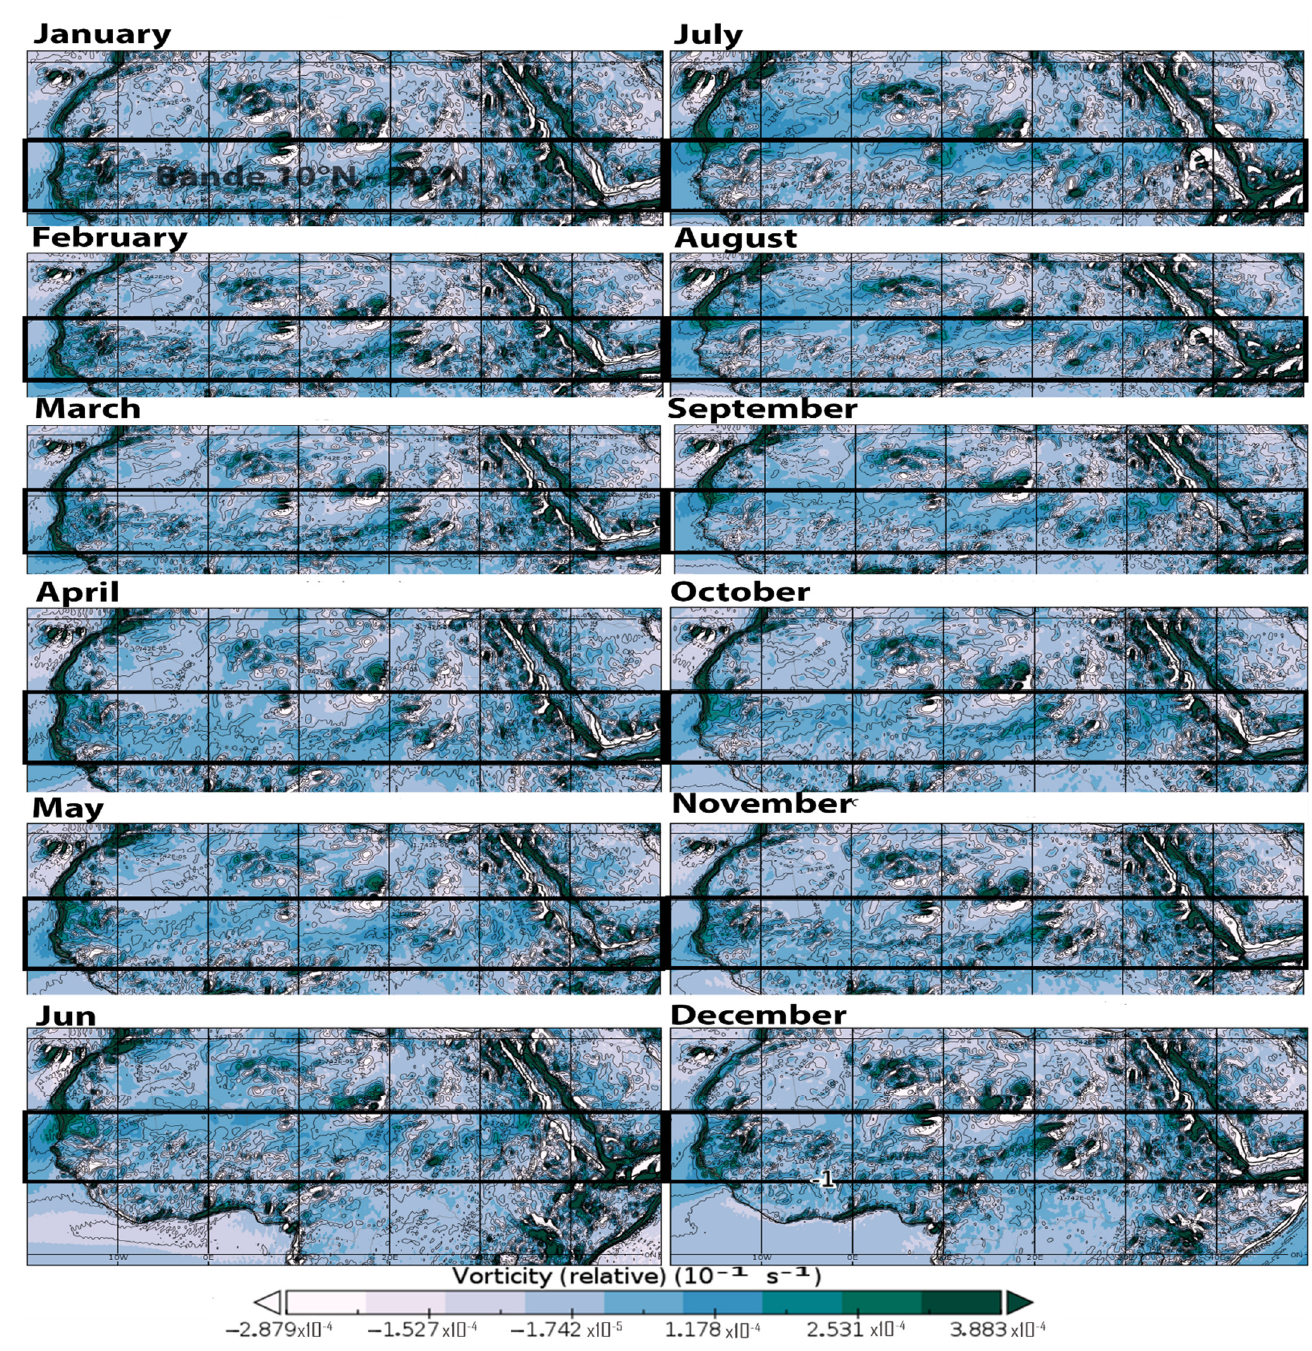
Figure 5. Climatology in monthly mean (4D-Var ERA5) vorticity in s − 1 from 1979 to 2008 with a resolution of 0.5 × 0.5 degrees. Data from the ERA5 platform.